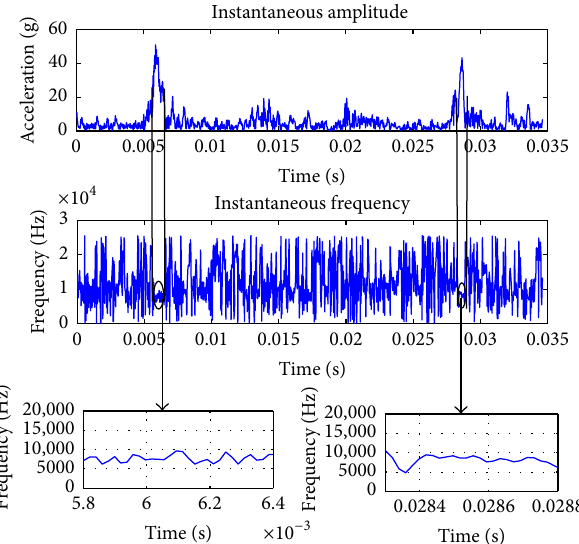
Figure 17: Hilbert transform results of IMF1 for cylinder block vibration signal.